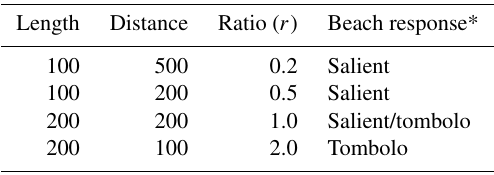
Table 1. Detached breakwaters considered for test case scenarios. Length Distance Ratio ( r ) Beach response* 100 500 0.2 Salient 100 200 0.5 Salient 200 200 1.0 Salient/tombolo 200 100 2.0